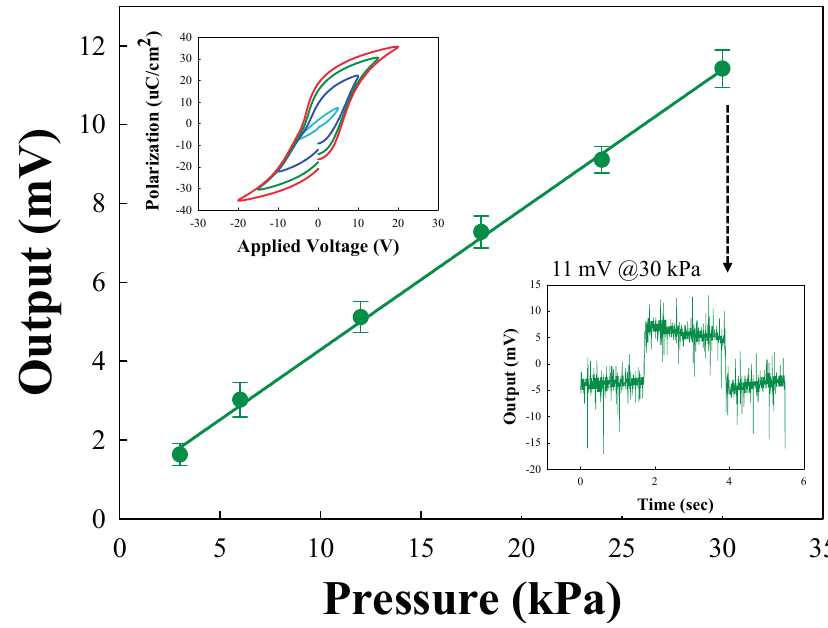
Figure 4. Electrical output with applied pressure on each piezo-sensor unit. The inset shows the P-E curve of the fabricated piezoelectric force